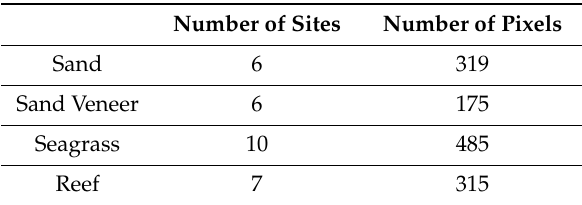
Figure 12. ( a ) Classification scheme for combined LiDAR reflectivity and multibeam backscatter data. ( b ) A classified map produced with LiDAR reflectivity and multibeam backscatter (SUTM50). Table 4. The number sites and pixels for each training class.